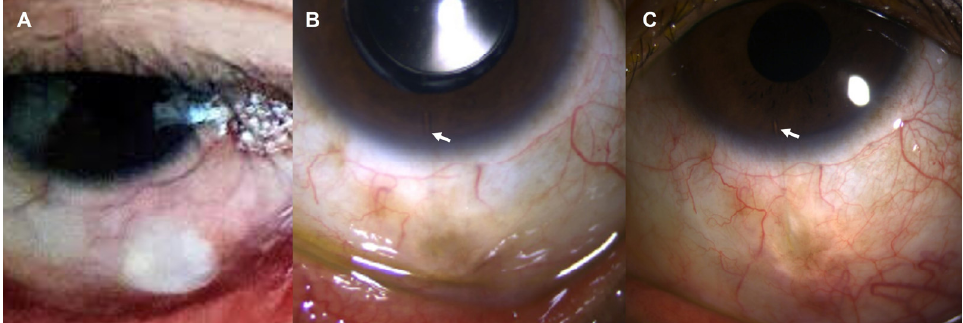
Figure 5. Slit-lamp photos of the left eye after the XEN ® Gel Stent implantation. ( A ) One month after the implantation, conjunctival bleb was prominent with intact conjunctiva. ( B ) At postoperative 1 year, conjunctival bleb was well maintained, which is still intact 3 years after the surgery ( C ). White arrow indicates XEN ® Gel Stent in the anterior chamber.